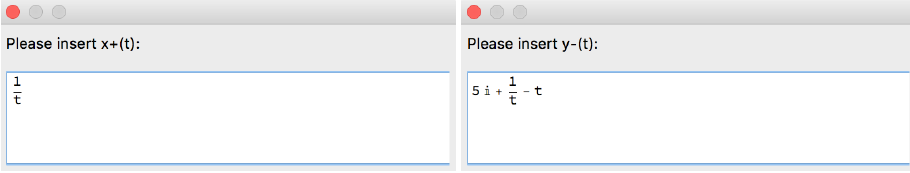
Figure 15. Part of the structure of the [SInt] algorithm corresponding to the Option 1 to input r .